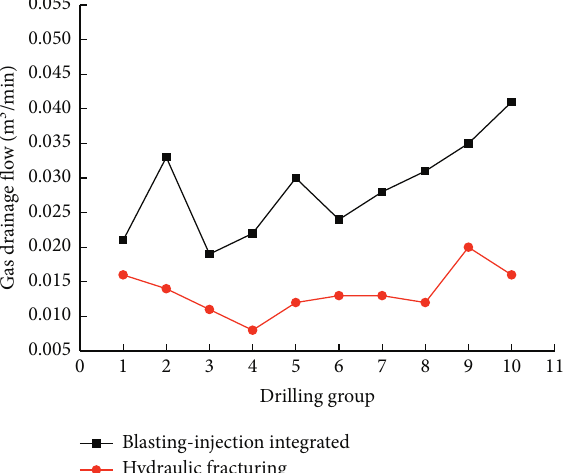
Figure 13: Comparison curve of gas drainage flow before and after blasting-injection integrated antireflection technology.